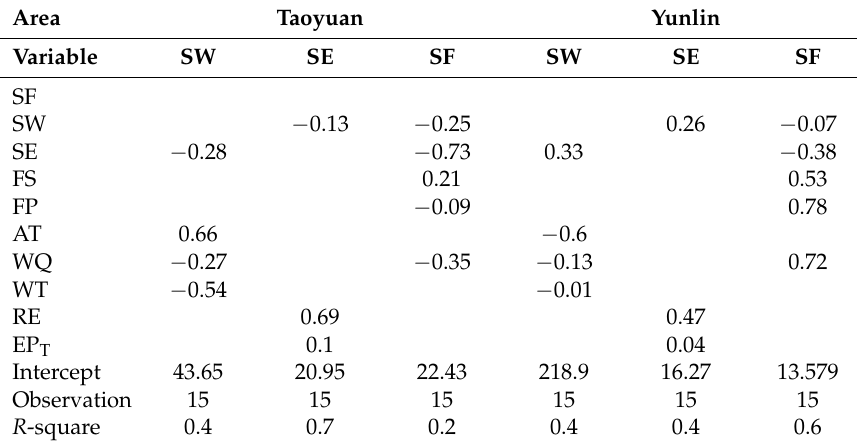
Table 3. Simultaneous equations model regression results in Taoyuan and